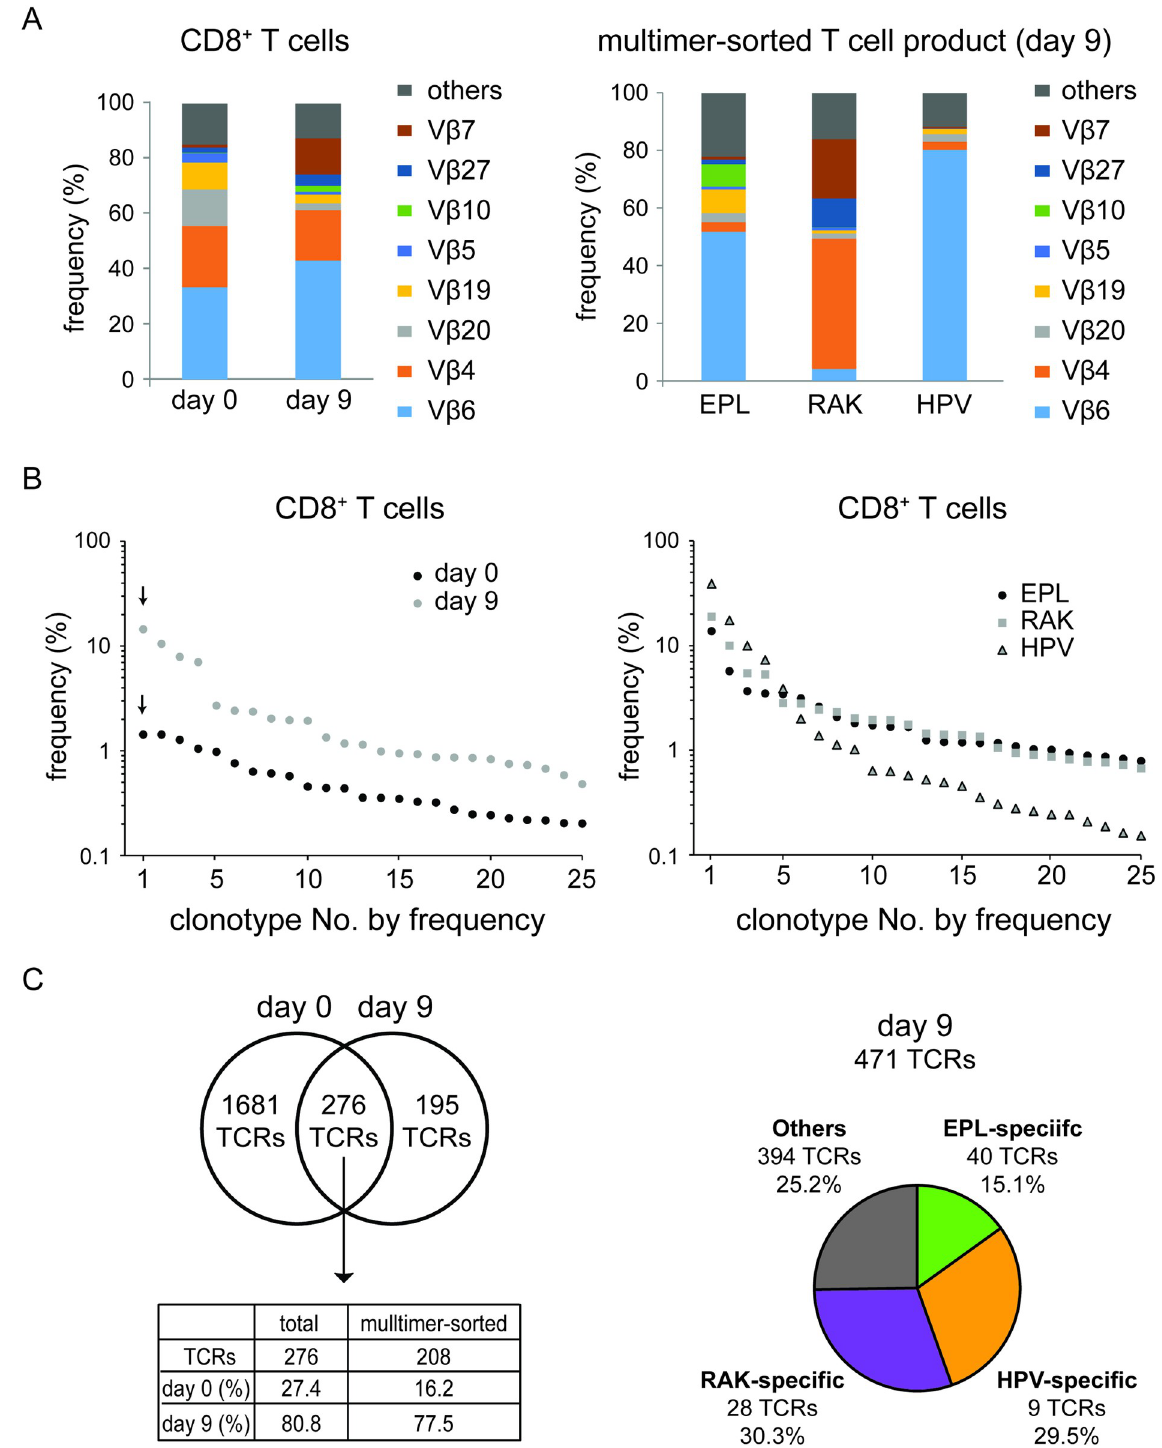
Fig 2. Global and EBV-specific TCR repertoire of the T cell product. (A) V β usage. Left panel: Percentage of V β subgroup usage within CD8 + T cells before (day 0) and after (day 9) peptide stimulation. Right panel: V β subgroup analysis of flow cytometry-sorted MHC multimer binding T cells (EPL, RAK, and HPV) on day 9 after peptide stimulation. (B) Individual clonotype distribution within CD8 + T cells on day 0 and day 9 (left panel) and in multimer-sorted T cells on day 9 (right panel). Each dot represents the frequency (percentage of all sequencing reads) of a single TCR β clonotype. The 25 most frequent clonotypes of each sample are illustrated. (C) Left panel: Overlap of the number of